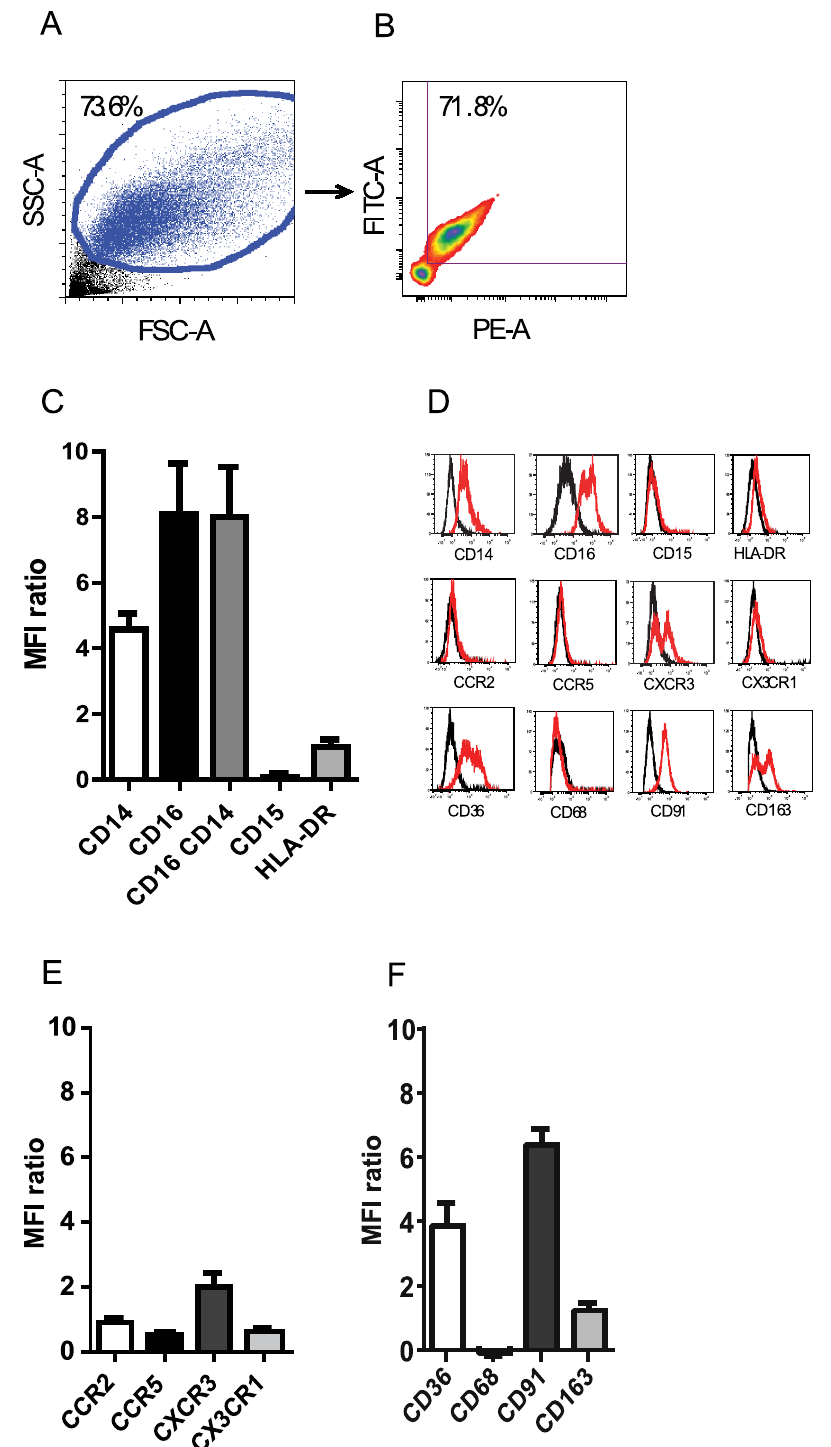
Fig 1. Surface immunophenotyping of BAL macrophages from healthy volunteers. (A) Alveolar macrophages obtained from the BAL of healthy volunteers were identified by size (FSC-A), granularity (SSC-A) and (B) autofluorescence. (C) Resident alveolar macrophage populations are CD14 + /CD16 + and HLA-DR lo /CD15 neg , as depicted by the mean fluorescence intensity (MFI) ratio where the MFI ratio = (MFI antigen -MFI control antibody )/ MFI control antibody [11]. (D) Histograms of surface antigens expressed by alveolar